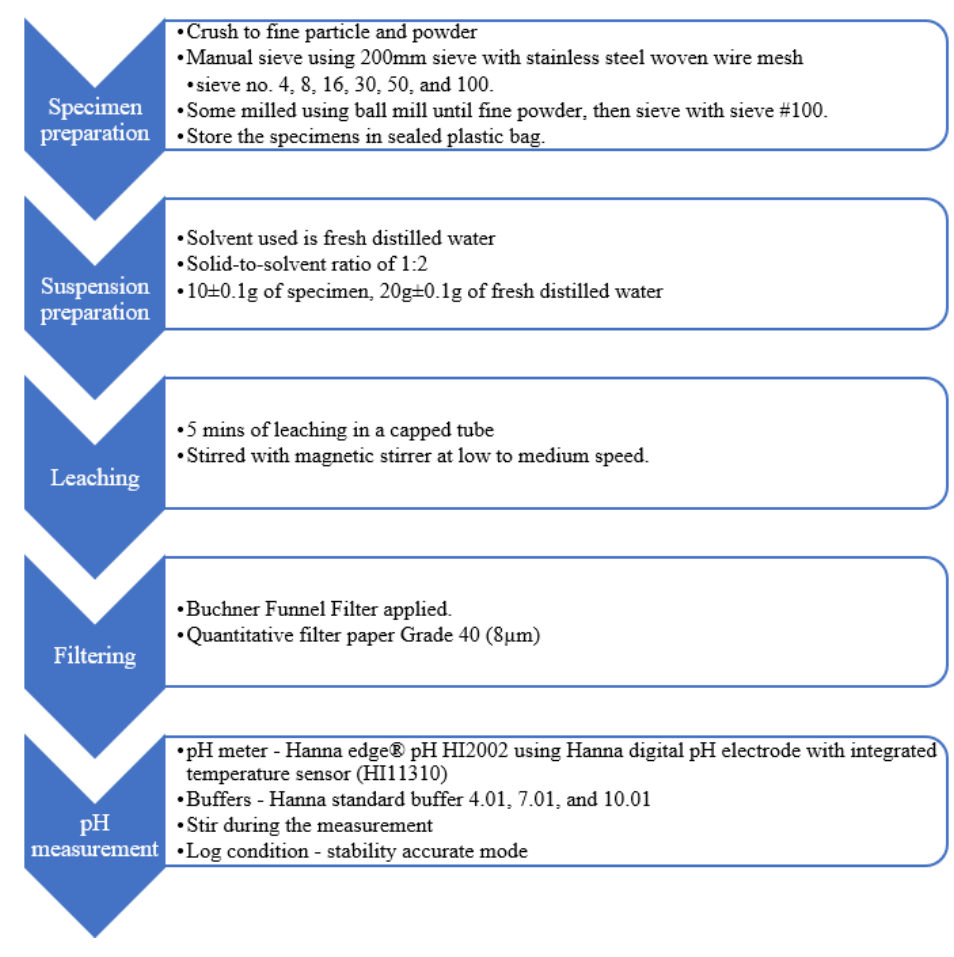
Figure 4. Benchmark methodology for effect of particle size.